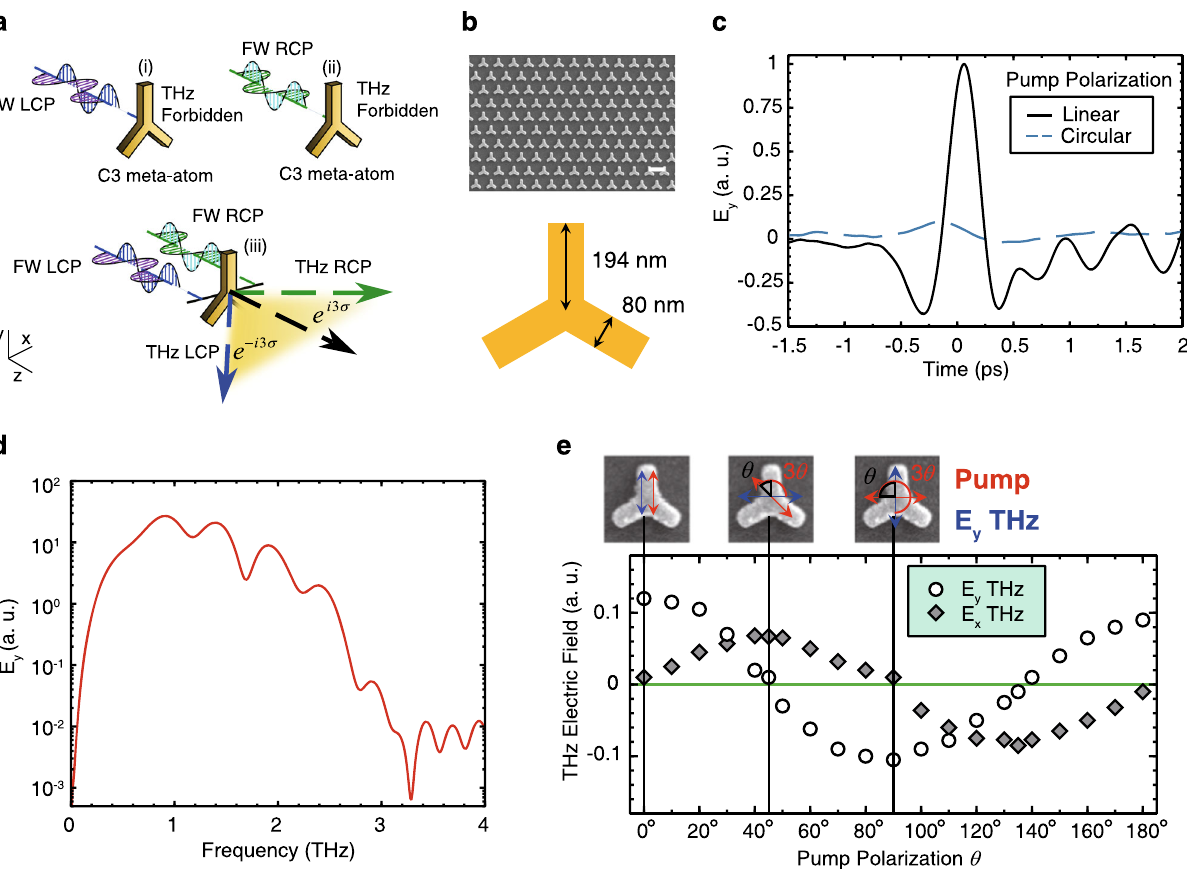
Fig. 1 Symmetry selection rules for THz wave generation using C3 meta-atoms. a Symmetry selection rules for generating THz pulses from a C3 meta- atom, with both circular spin states of the pump beam required for THz generation. Excitation of the C3 meta-atom with only LCP or RCP FW's results in no generated THz signal. b C3 meta-atom dimensions and sample orientation. Scale bar = 550 nm. c Generation of a single-cycle THz pulse with linear E y polarization after irradiation with near infrared femtosecond pulses with linear E x polarization. d Corresponding frequency spectrum of the generated THz pulse, ranging from 0.6 to over 2 THz. e The detected E y and E x components of the THz fi eld are shown relative to the rotation of the fundamental pump polarization. The maxima and minima occur due to a 3 θ rotation of the THz linear polarization relative to the pump pulse as shown in the inset for the E y fi eld at θ ¼ 0 (cid:2) ; Δ θ ¼ 0 (cid:2) ; θ ¼ 45 (cid:2) ; Δ θ ¼ 135 (cid:2) ; θ ¼ 90 (cid:2) ; Δ θ ¼ 270 (cid:2) . Corresponding E fi elds occur at pump x peak pump THz (cid:3) pump pump THz (cid:3) pump pump THz (cid:3) pump pulse polarization angles of θ pump ¼ 45 (cid:2) and 135 (cid:2)